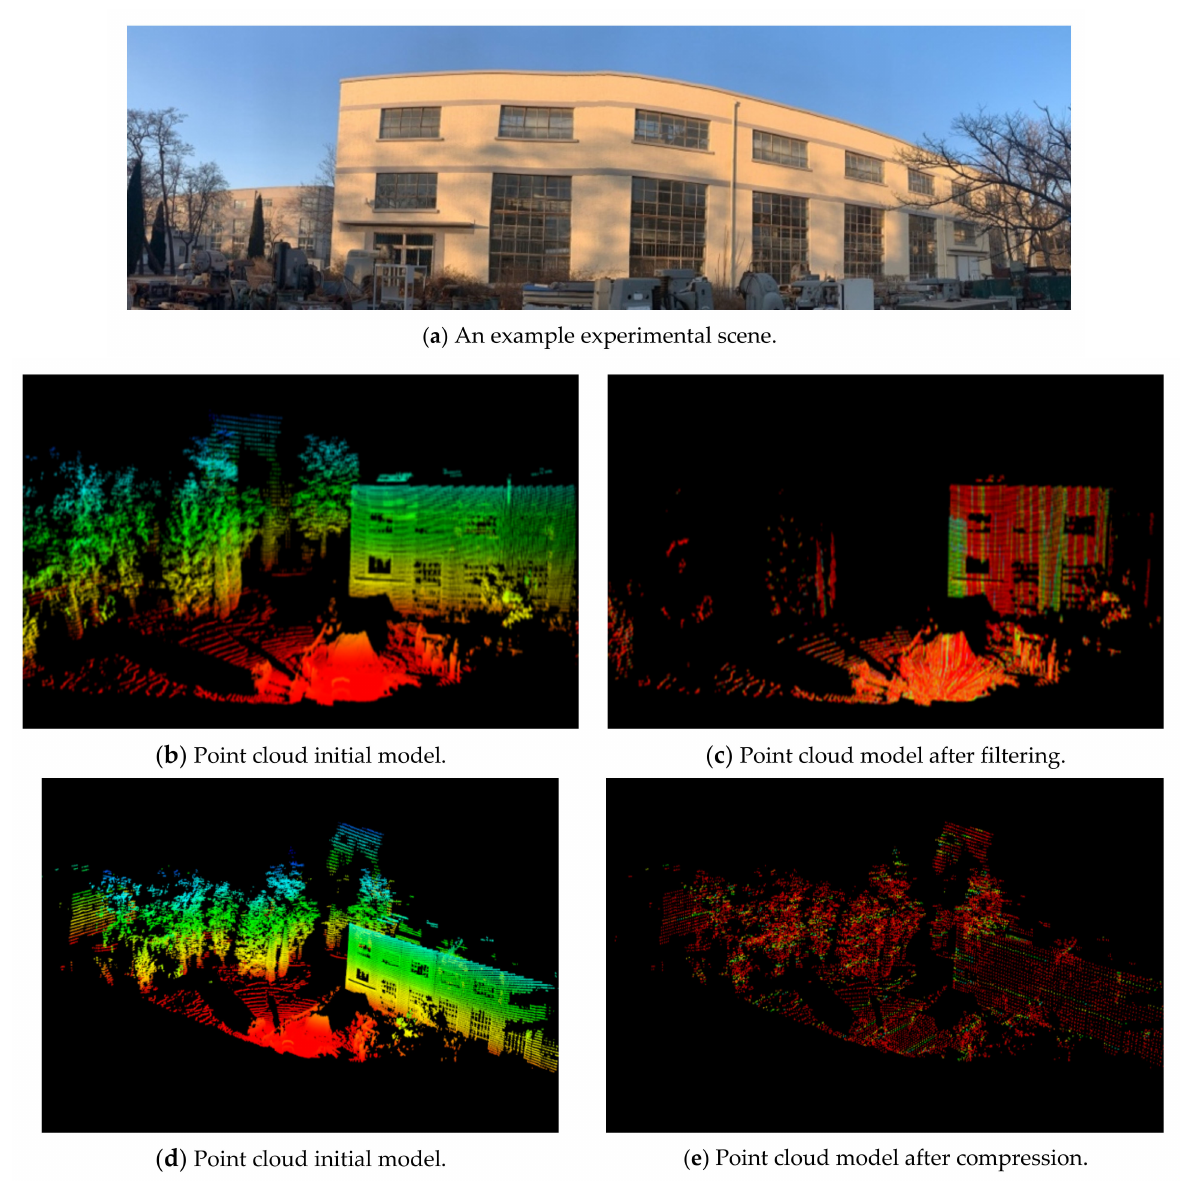
Figure 8. Comparison of point cloud with and without filtering and